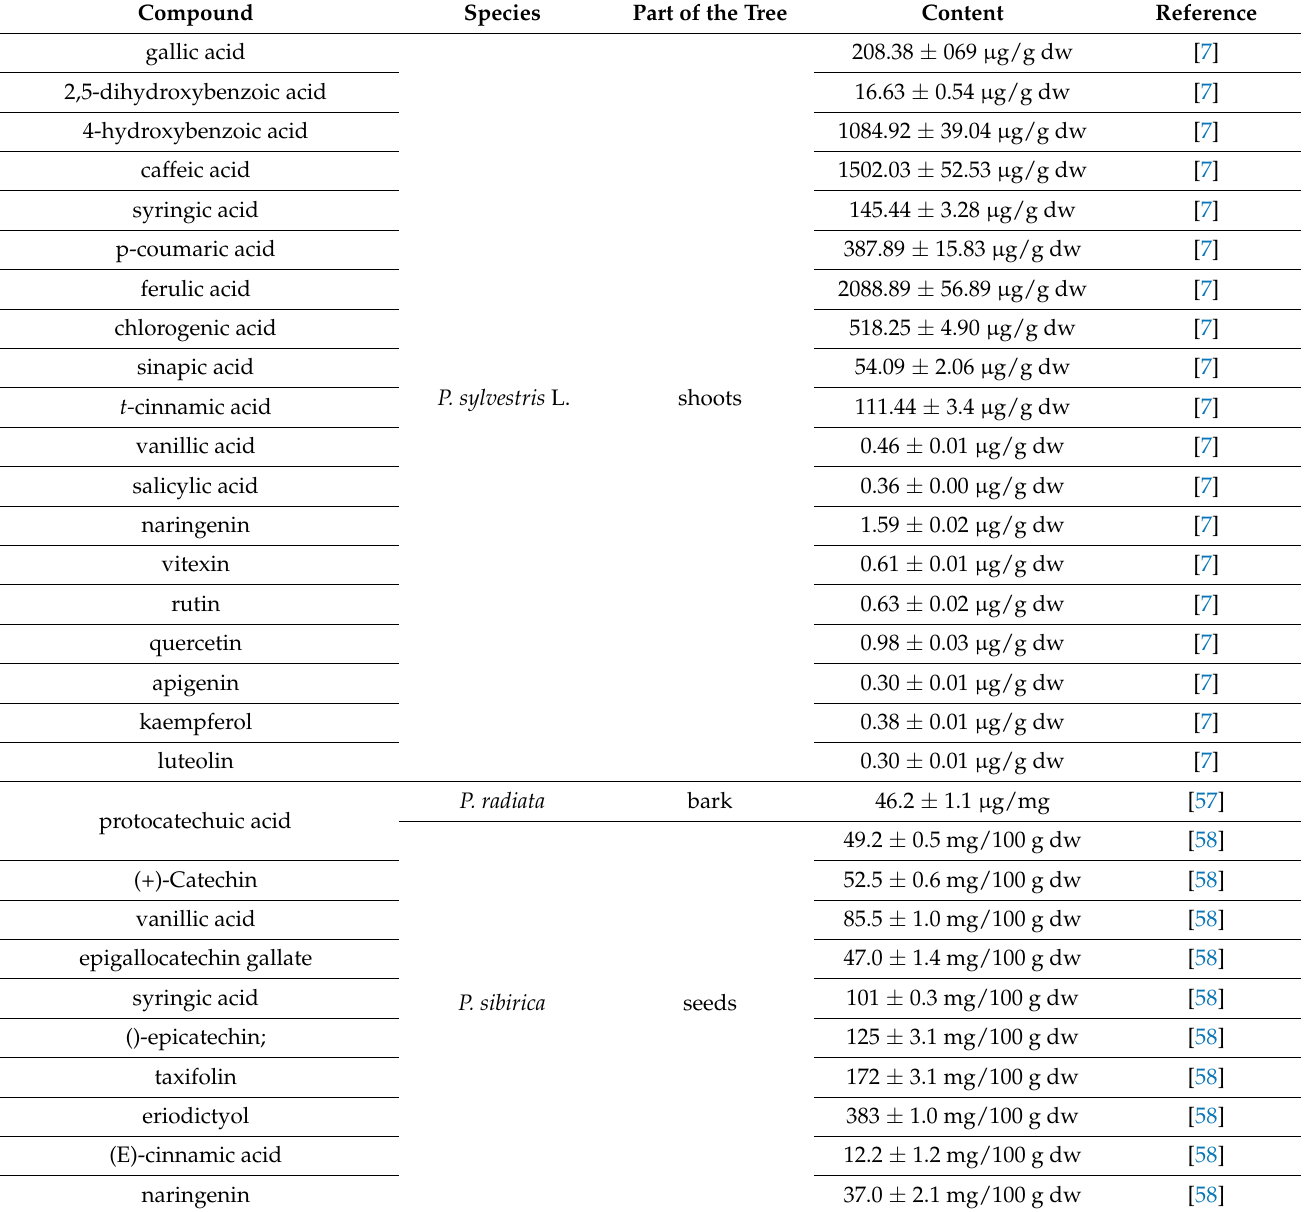
Table 4. Polyphenol